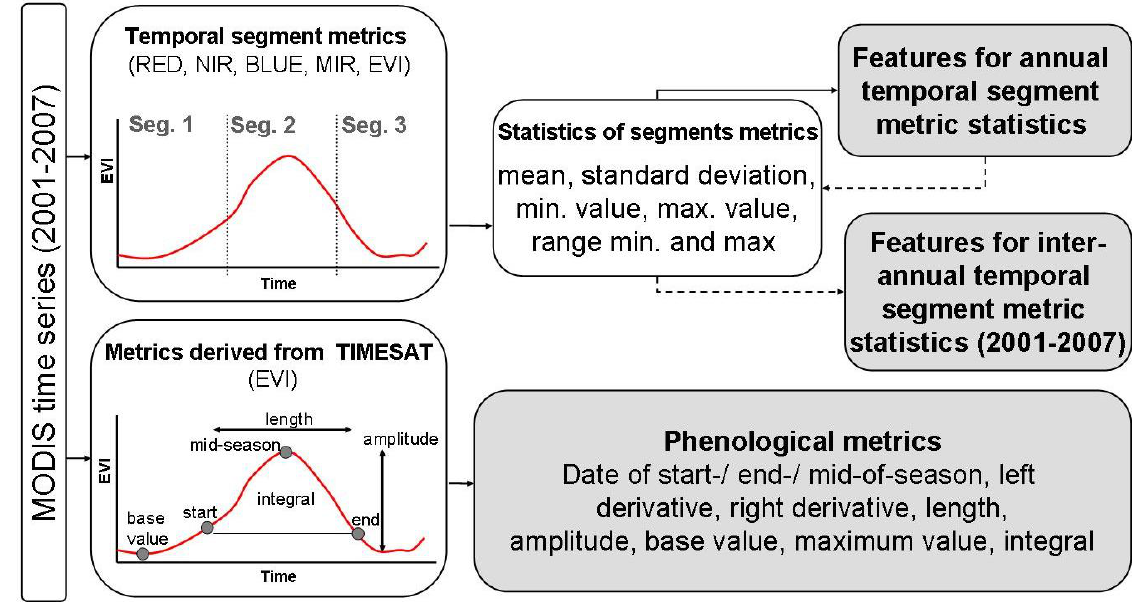
Figure 3. Flowchart of the extraction of intensity-related temporal segment metrics and phenological time series metrics derived from the TIMESAT software [52]. Note the resulting feature sets for the classification in the grey